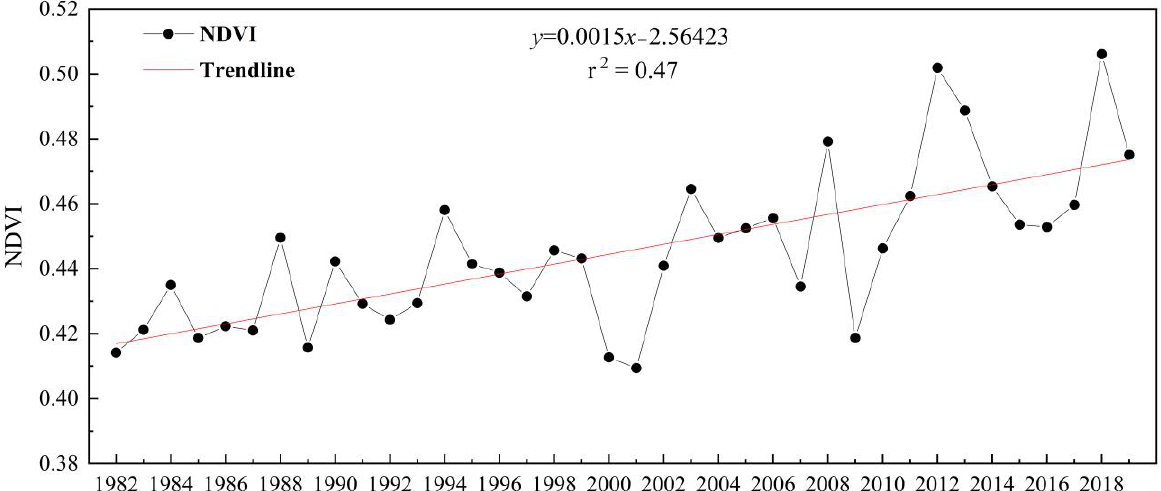
Figure 5. Change trend of the annual NDVI over time. The black points are the average value of NDVI of Inner Mongolia in each year. The red line is the trend fitting line. The slope of the trend line is 0.0015, p < 0.05.